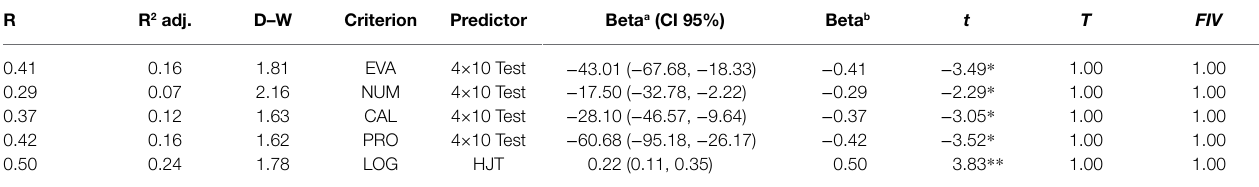
TABLE 3 | Linear regression